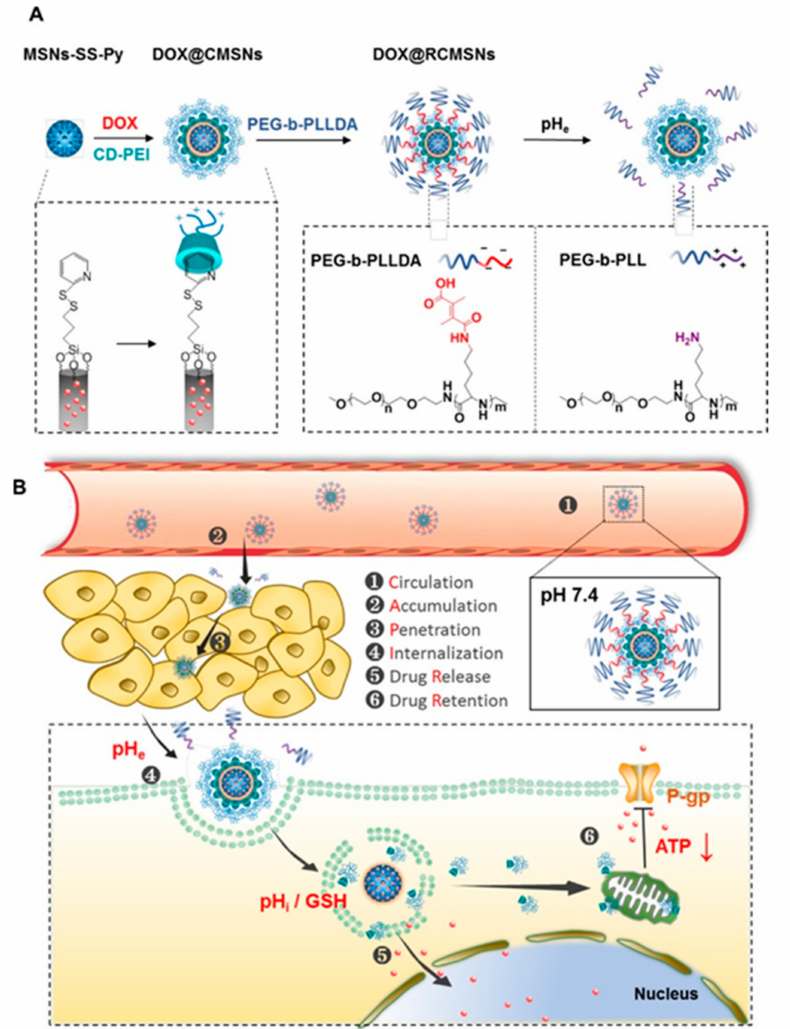
Figure 1. ( A ) Schematic showing the synthetic procedure of the sequentially responsive nanosystem (DOX@RCMSNs). ( B ) Schematic illustration of DOX@RCMSNs overcoming the cascaded bio-barriers and the mechanism of action in tumor cells. Adapted from